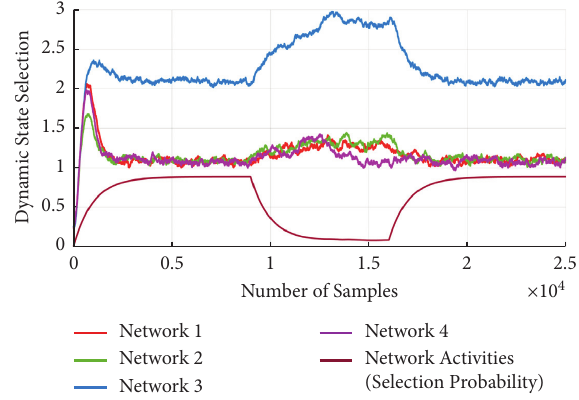
Figure 15: Effect of threshold on network connectivity for threshold � 2 ( S l � 2).